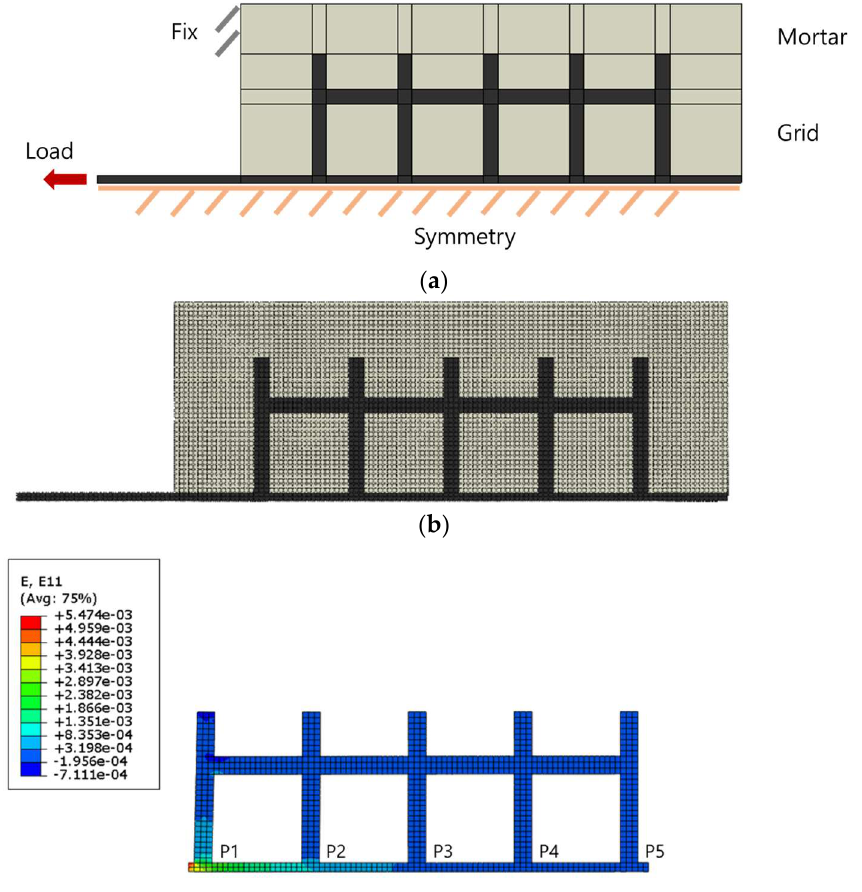
Figure 13. ( a ) Boundary condition, ( b ) finite element model, and ( c ) strain results of CFRP grid.